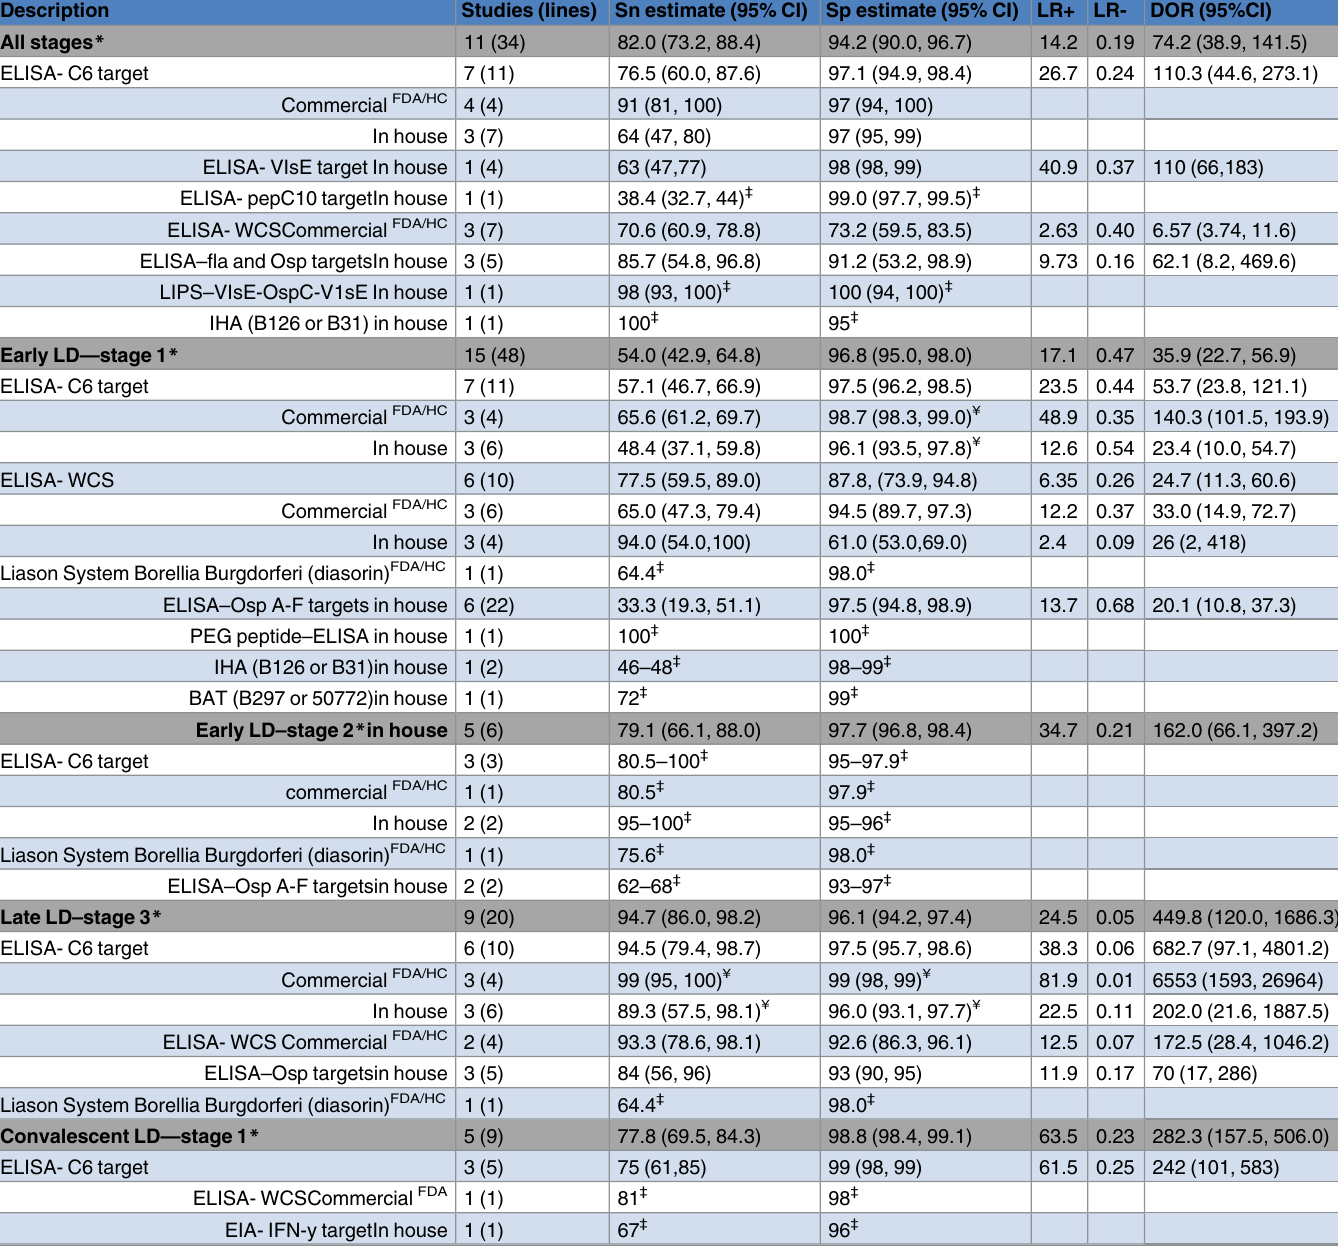
Table 3. Twenty three studies (119 lines of data) evaluating different assays(mainly 1 st tier tests) by stage of Lyme disease using hierarchical logistic regression models or simply sensitivity and specificity when less than four lines of data were available for meta-analysis.